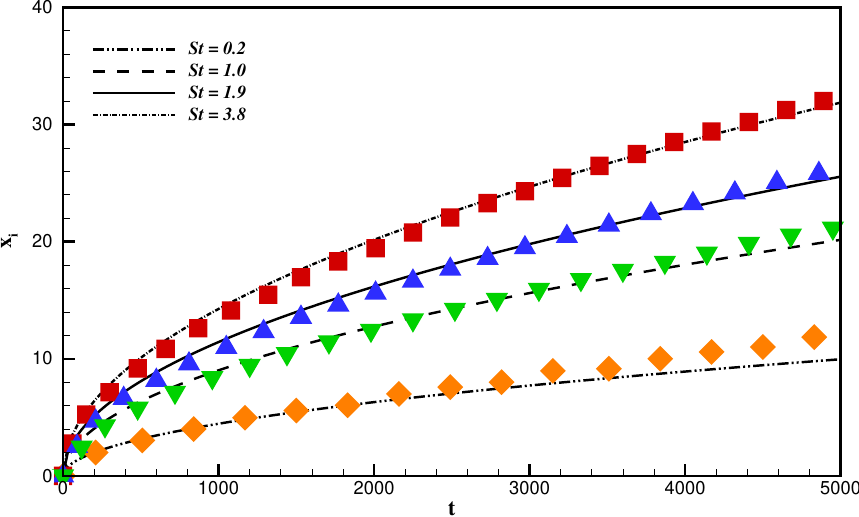
Figure 3. Location of the interface versus time in lattice units for four different Stefan numbers. Line: Analytical solution. Symbols: Present